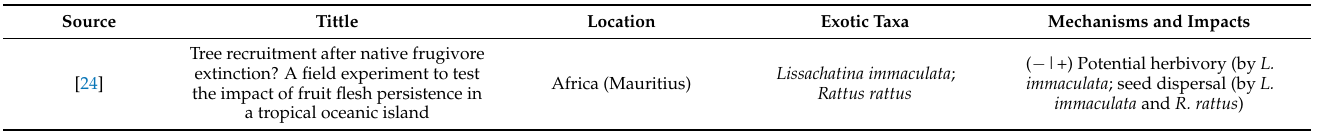
Table A1. List of reviewed articles, including exotic taxa involved in each study and their ecological impacts and